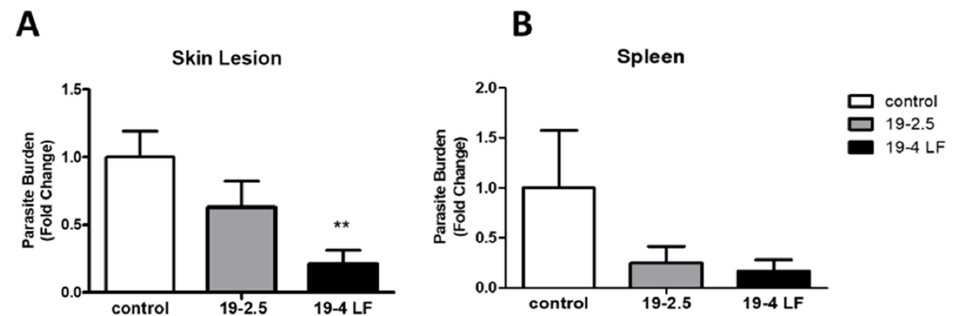
Figure 3. Effect of peptides 19-2.5 and 19-4 LF on parasite burden in the skin lesions ( A ) and the spleen ( B ) of L. major infected mice after treatment compared to controls (untreated mice). The parasite burden was evaluated by quantifying the Lm18S mRNA gene expression levels using qPCR method. Bars represent the mean ± the SD. Significant difference was indicated (**, p < 0.01 compared with the untreated control).